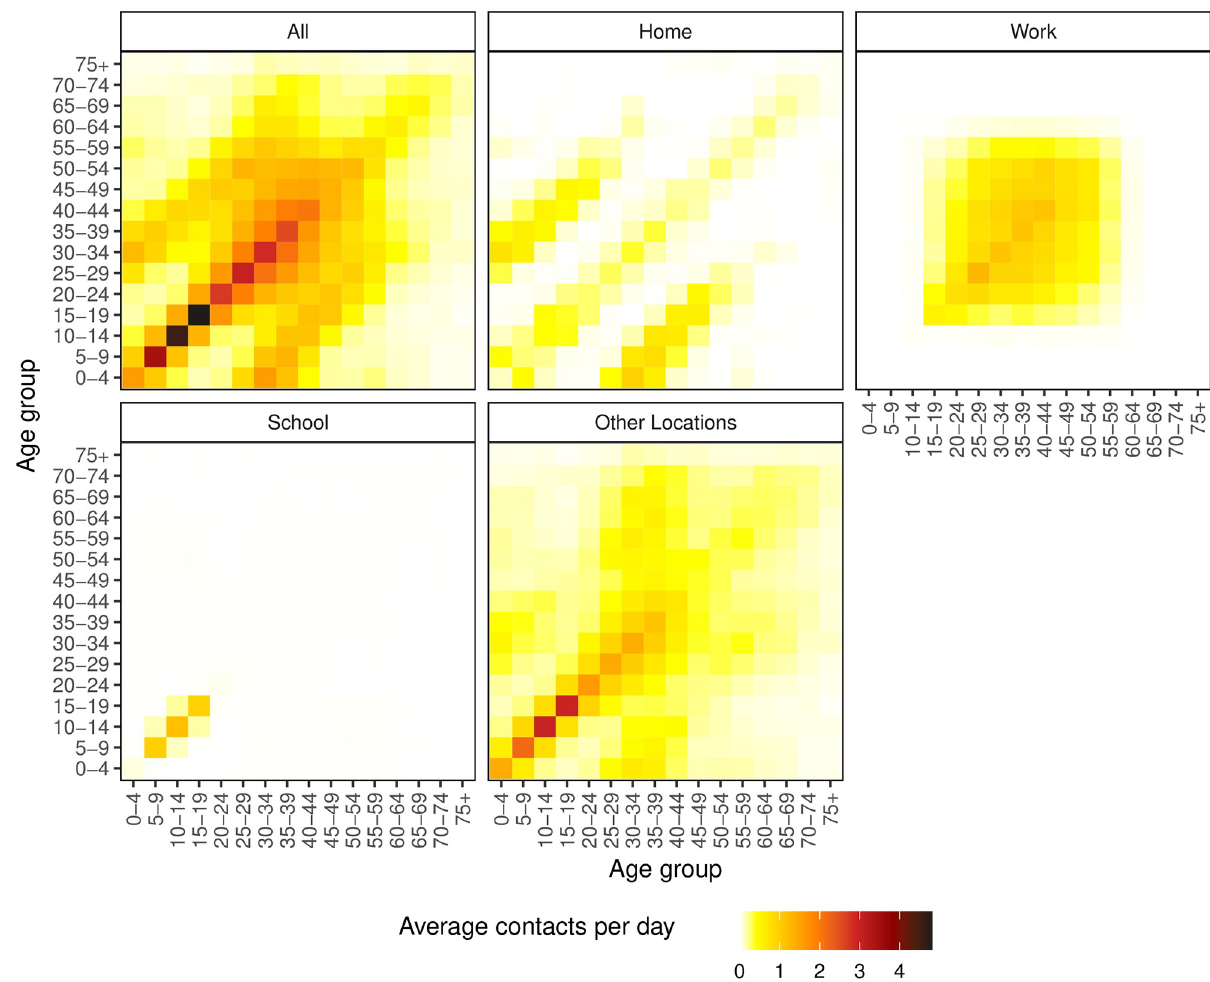
Fig 2. Estimated social contact matrices for Irish population mixing at 5 year intervals [21].